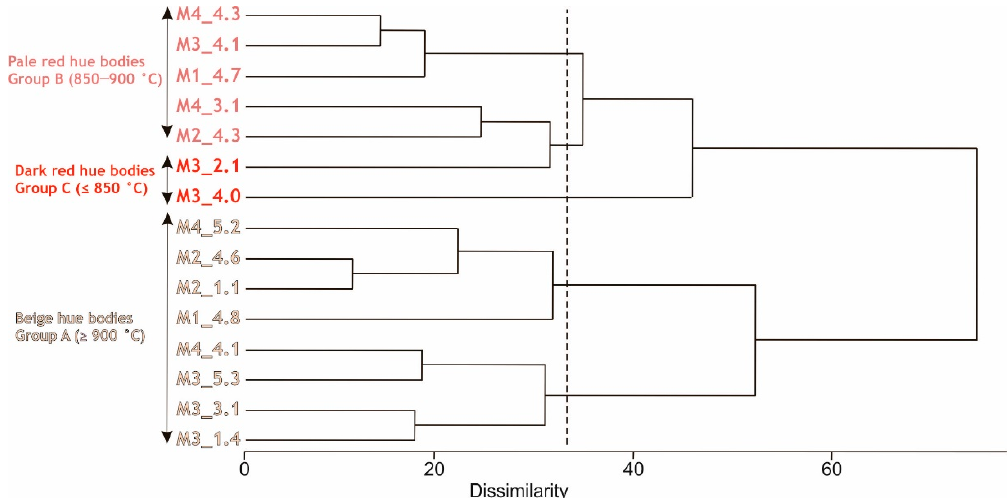
Figure 7. Dendrogram obtained from the cluster analysis of PXRD data according to Euclidean distance and average linkage method on position of peaks. Firing temperature, determined according to the mineralogical association, is also reported, as well as the color of the ceramic bodies.